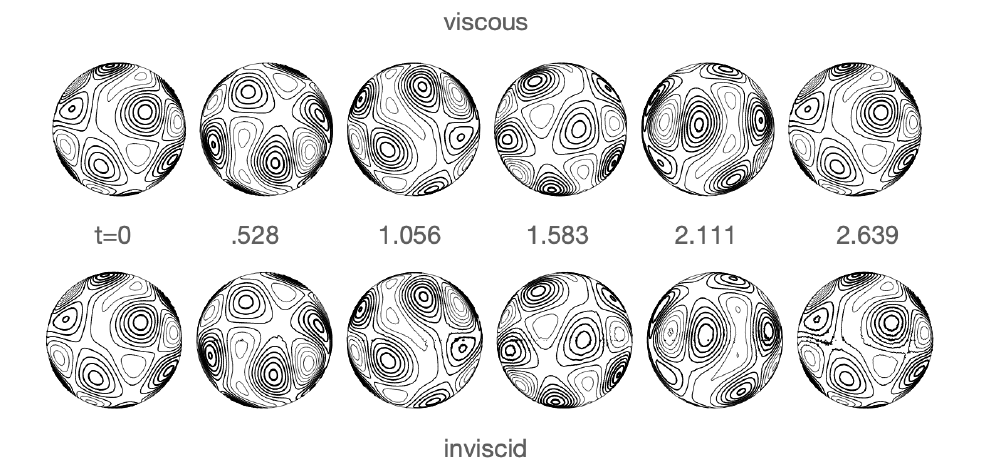
Figure 5. Vorticity as seen from x = ∞ at 6 times in two solutions in which the angular momentum vector points in the y -direction. z increases upward in the figure. The initial state at t = 0 consists only of harmonics of degree n = 6. The pattern rotates upward in the figure, around the sphere, to return to its original location at the predicted time t = 2.639. The inviscid solution shows small, grid-scale oscillations in the vorticity that do not appear in the viscous